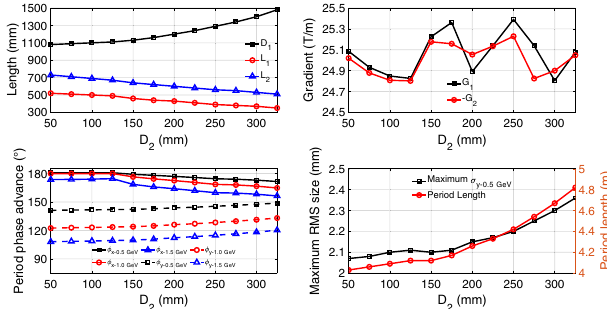
FIG. 6. Optimization on D 2 and D 1 . (With D 2 increases, D 1 is increasing, while L 1 and L 2 are decreasing; the gradient is limited within 25 (cid:3) 0 . 5 T = m; periodic phase advance increases in Y plane and decreases from about 180° in X plane; beam maximum RMS size and period length are increasing roughly.)